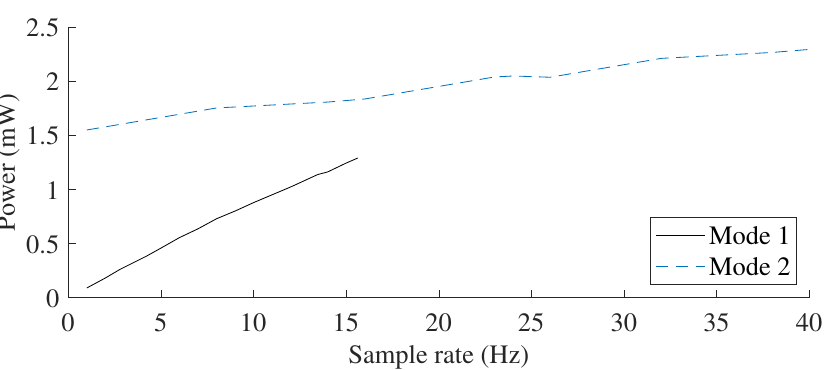
Figure 6. The average power requirement as a function of sample rate for the wireless sensor working in the two operating modes with a constant supply voltage of 1.8V.